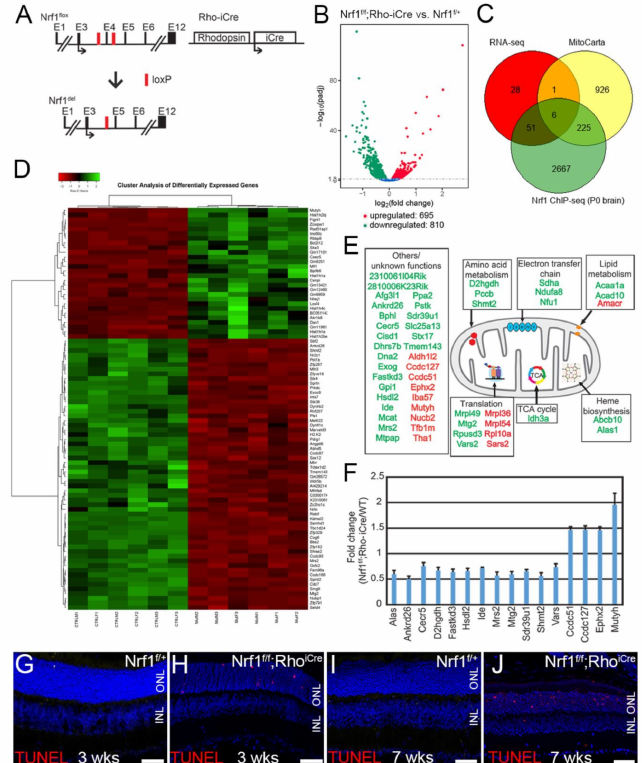
Figure 5. Nrf1 conditional deletion by Rho iCre causes dynamic gene expression alteration before the onset of photoreceptor degeneration. ( A ) Schematic representation of Nrf1 flox allele, Nrf1 deleted allele, and Rho iCre allele. Exons are indicated as E1–E12. Black arrows indicate the translational start sites for Nrf1 and iCre protein. Red boxes indicate loxP sites. ( B ) Volcano plot showing the differentially expressed genes. The x -axis indicates the log 2 fold change of genes between mutant and control. The y -axis indicates the − log 10 (adjusted p -value). Each dot represents a gene. Blue dots indicate no significant difference; red dots indicate upregulated DEGs; green dots indicate downregulated DEGs. ( C ) Venn diagram showing coexpressed genes among the three gene lists described in the text. ( D ) Hierarchical clustering heatmap showing the 86 most sensitive, early responsive DEGs in rod-specific Nrf1 -deleted retinas. ( E ) Schematic mapping of mitochondrion and functional annotation of upregulated (red) and downregulated (green) genes in Nrf1 f/f ; Rho iCre retinas detected by RNA-seq. ( F ) qRT-PCR analysis of wild-type and Nrf1 f/f ; Rho iCre retinas, confirming the changes of mRNA levels detected by RNA-seq. ( G – J ) TUNEL assay of 3- and 7-week-old Nrf1 f/+ ( G , I ) and Nrf1 f/f ; Rho iCre ( H , J ) retinas. ONL: outer nuclear layer. INL: inner nuclear layer. Scale bars: 50 µ